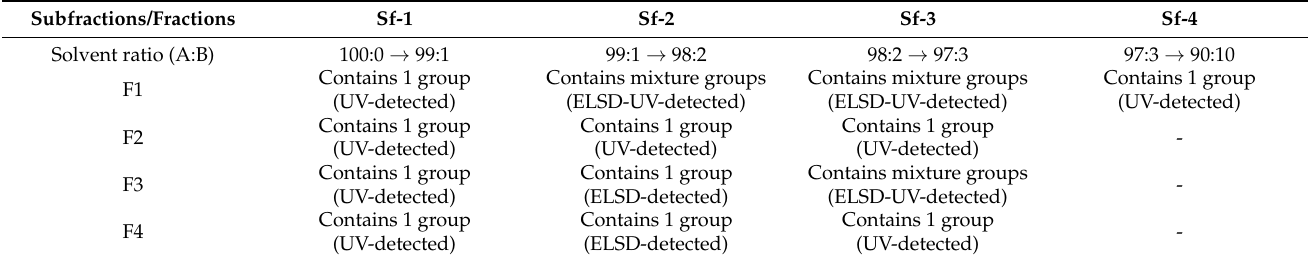
Table 3. Description of the subfractions obtained by preparative